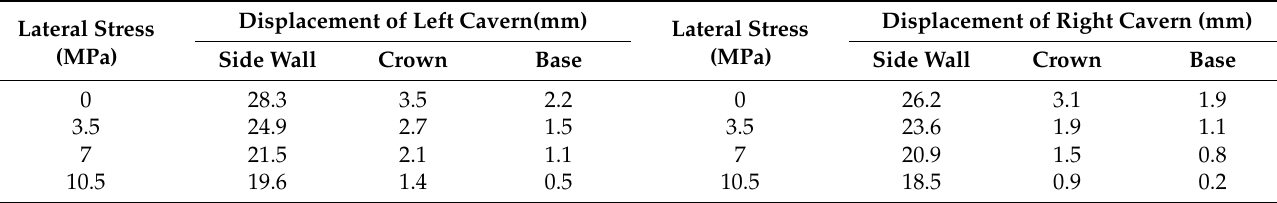
Table 9. Displacement of caverns under different lateral